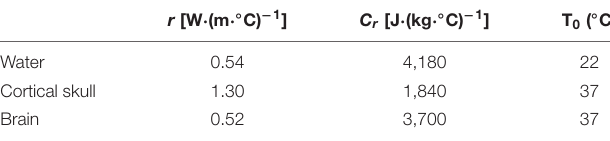
TABLE 3 | Constant parameters for the temperature field simulation.